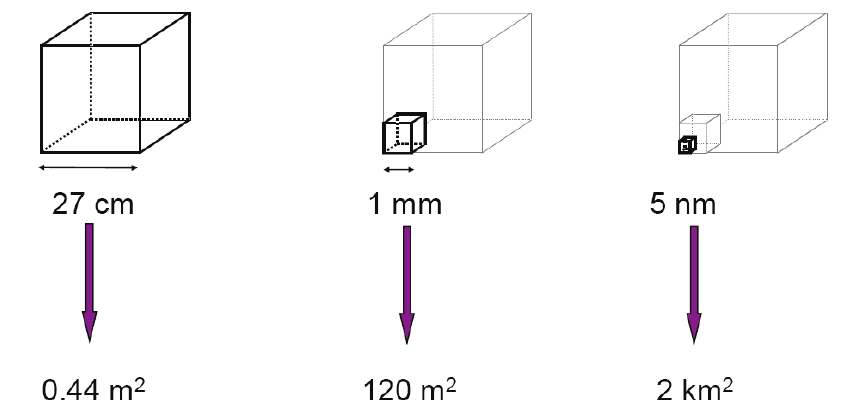
Figure 1. Schematic representation of the increasing surface area while decreasing particle size, using a 50 kg quartz cube. The cubes are not true to